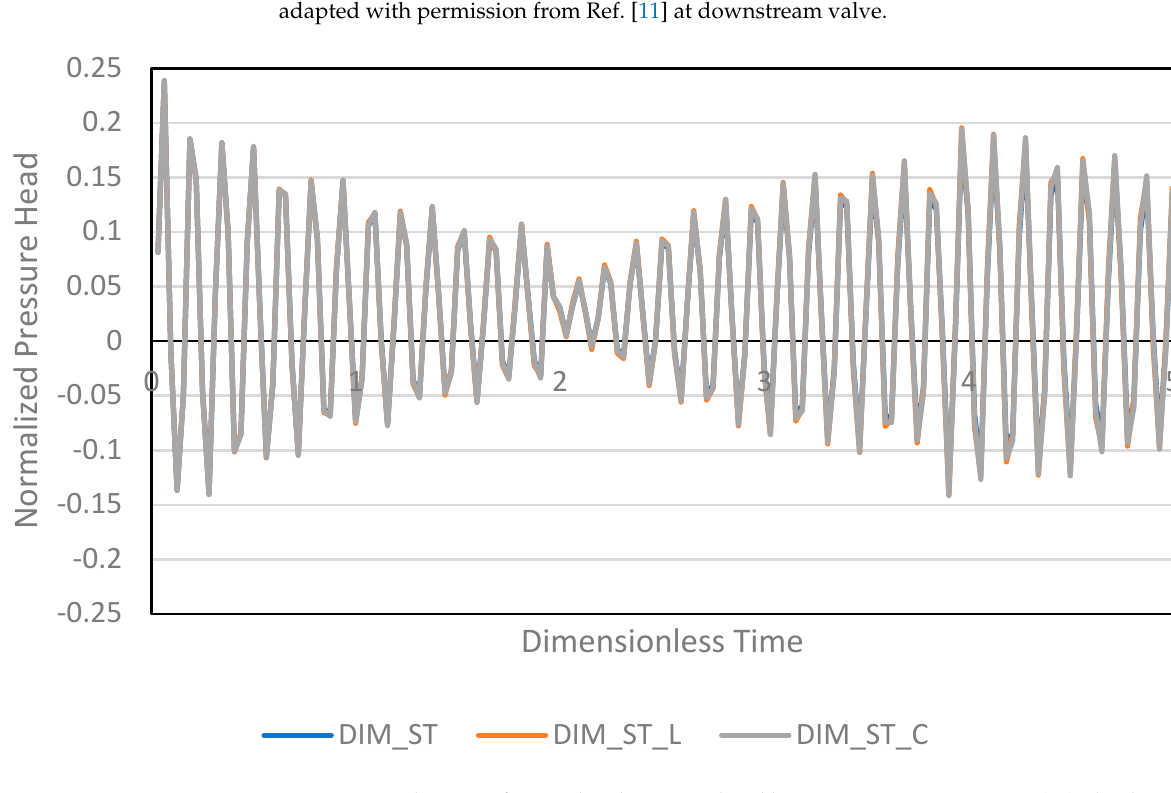
Figure 4. Predictions of normalized pressure head by DIM_ST using Equation (28), the dimensionless lumped inertia (DIM_ST_L) using Equation (33), and the conventional pipeline scheme for the connector (DIM_ST_C) using Equation (29) at the surge tank connector in the main pipeline .